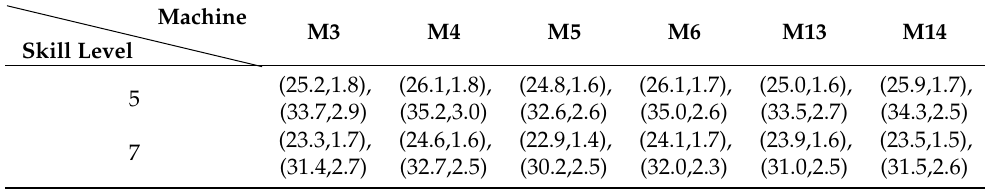
Table 4. Time distributions of completing subtask c 1 cooperatively (Unit: Min).